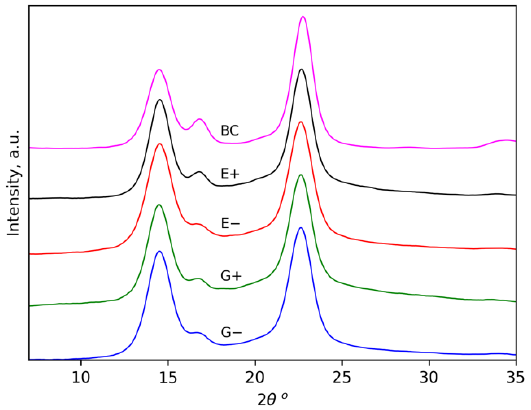
Figure 5. X-ray diffraction patterns of initial BC and BC-NF samples prepared under different conditions.